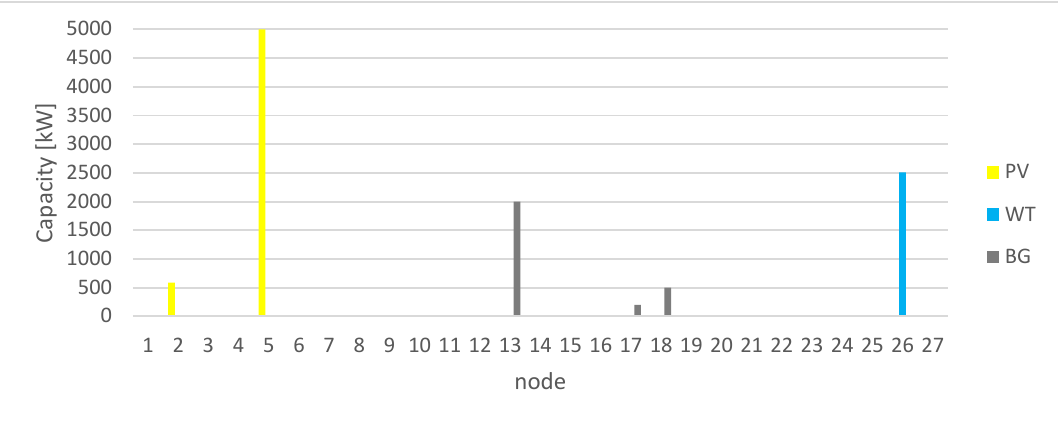
Figure A5. Capacity structure for scenario “3”.